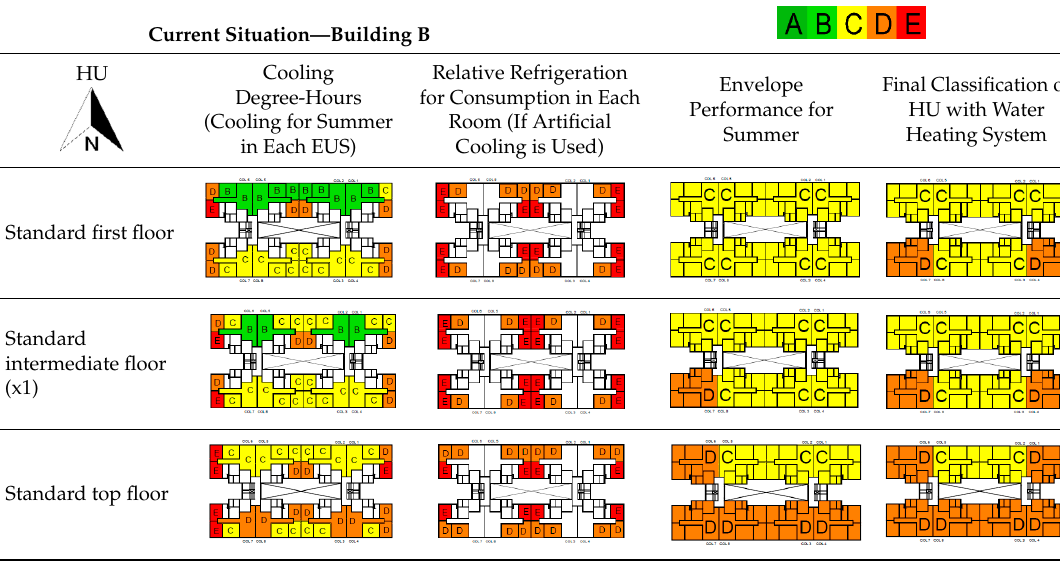
Table 4. Comparison of the conformity of representative buildings with the quality technical regulation for the energy efficiency level of residential buildings (RTQ-R) requirements for bioclimatic zone (BZ) 8. Table 7. Graphical representation of the standard floor of Representative Building C with the classification based on energy efficiency evaluation. Table 6. Graphical representation of the standard floor of Representative Building B with the Table 6. Graphical representation of the standard floor of Representative Building B with the Table 6. Graphical representation of the standard floor of Representative Building B with the Table 6. Graphical representation of the standard floor of Representative Building B with the classification based on energy efficiency assessment. classification based on energy efficiency assessment. classification based on energy efficiency assessment. classification based on energy efficiency assessment. Table 6. Graphical representation of the standard floor of Representative Building B with the Table 6. Graphical representation of the standard floor of Representative Building B with the Table 6. Graphical representation of the standard floor of Representative Building B with the Table 6. Graphical representation of the standard floor of Representative Building B with the classification based on energy efficiency assessment. classification based on energy efficiency assessment. classification based on energy efficiency assessment. classification based on energy efficiency assessment. Table 6. Graphical representation of the standard floor of Representative Building B with the Table 6. Graphical representation of the standard floor of Representative Building B with the Table 6. Graphical representation of the standard floor of Representative Building B with the Table 6. Graphical representation of the standard floor of Representative Building B with the Table 6. Graphical representation of the standard floor of Representative Building B with the Table 6. Graphical representation of the standard floor of Representative Building B with the Table 6. Graphical representation of the standard floor of Representative Building B with the Table 6. Graphical representation of the standard floor of Representative Building B with the Table 6. Graphical representation of the standard floor of Representative Building B with the Table 6. Graphical representation of the standard floor of Representative Building B with the Table 6. Graphical representation of the standard floor of Representative Building B with the Table 6. Graphical representation of the standard floor of Representative Building B with the Table 6. Graphical representation of the standard floor of Representative Building B with the Table 6. Graphical representation of the standard floor of Representative Building B with the Table 6. Graphical representation of the standard floor of Representative Building B with the Table 6. Graphical representation of the standard floor of Representative Building B with the Table 6. Graphical representation of the standard floor of Representative Building B with the Table 6. Graphical representation of the standard floor of Representative Building B with the classification based on energy efficiency assessment. classification based on energy efficiency assessment. classification based on energy efficiency assessment. classification based on energy efficiency assessment. classification based on energy efficiency assessment. classification based on energy efficiency assessment. classification based on energy efficiency assessment. classification based on energy efficiency assessment. classification based on energy e ffi ciency assessment. classification based on energy efficiency assessment. classification based on energy efficiency assessment. classification based on energy efficiency assessment. classification based on energy efficiency assessment. classification based on energy efficiency assessment. classification based on energy efficiency assessment. classification based on energy efficiency assessment. classification based on energy efficiency assessment. classification based on energy efficiency assessment.